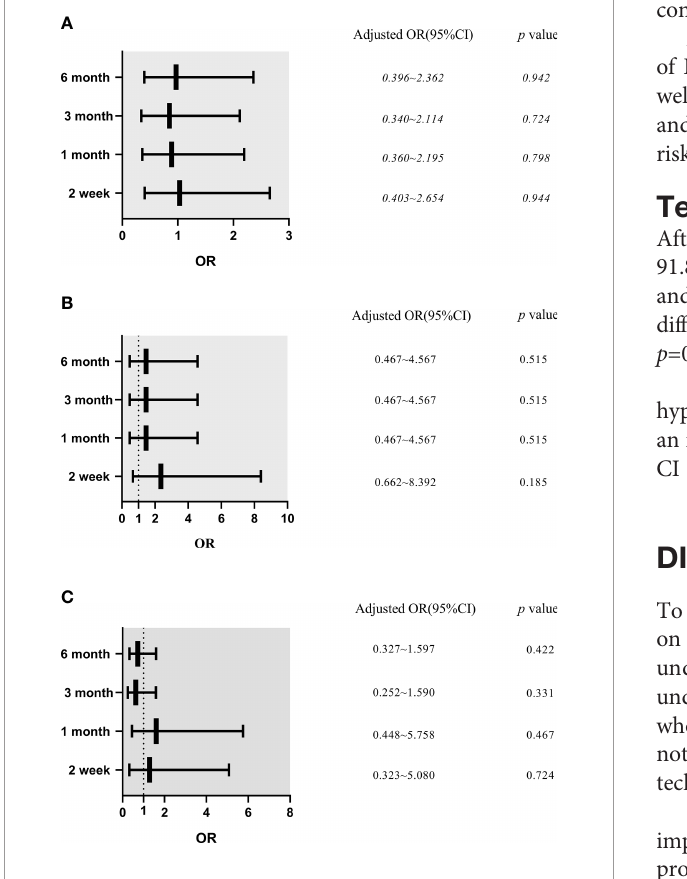
FIGURE 2 | The effects of break-in period on mechanical complications, catheter migration and infectious complications in different follow-up time (Logistic Multivariate Analysis). (A) Mechanical complications. Model was adjusted for peritoneal dialysis center, age, temporary hemodialysis usage, abdominal surgery history, white blood cells, hemoglobin, creatinine, blood urea nitrogen, blood potassium, blood phosphorus. (B) Catheter migration. Model was adjusted for peritoneal dialysis center, temporary hemodialysis usage, hypertension, abdominal surgery history, white blood cells, blood urea nitrogen and blood phosphorus. (C) Infectious complications. Model was adjusted for peritoneal dialysis center, temporary hemodialysis usage, sex, cause of end stage renal disease, hypertension, abdominal surgery history, white blood cells, hemoglobin, blood albumin, high-density lipoprotein cholesterol, low-density lipoprotein cholesterol, blood urea nitrogen, blood uric acid, creatinine, blood calcium, blood phosphorus and blood glucose. OR, odds ratio; CI, con fi dence